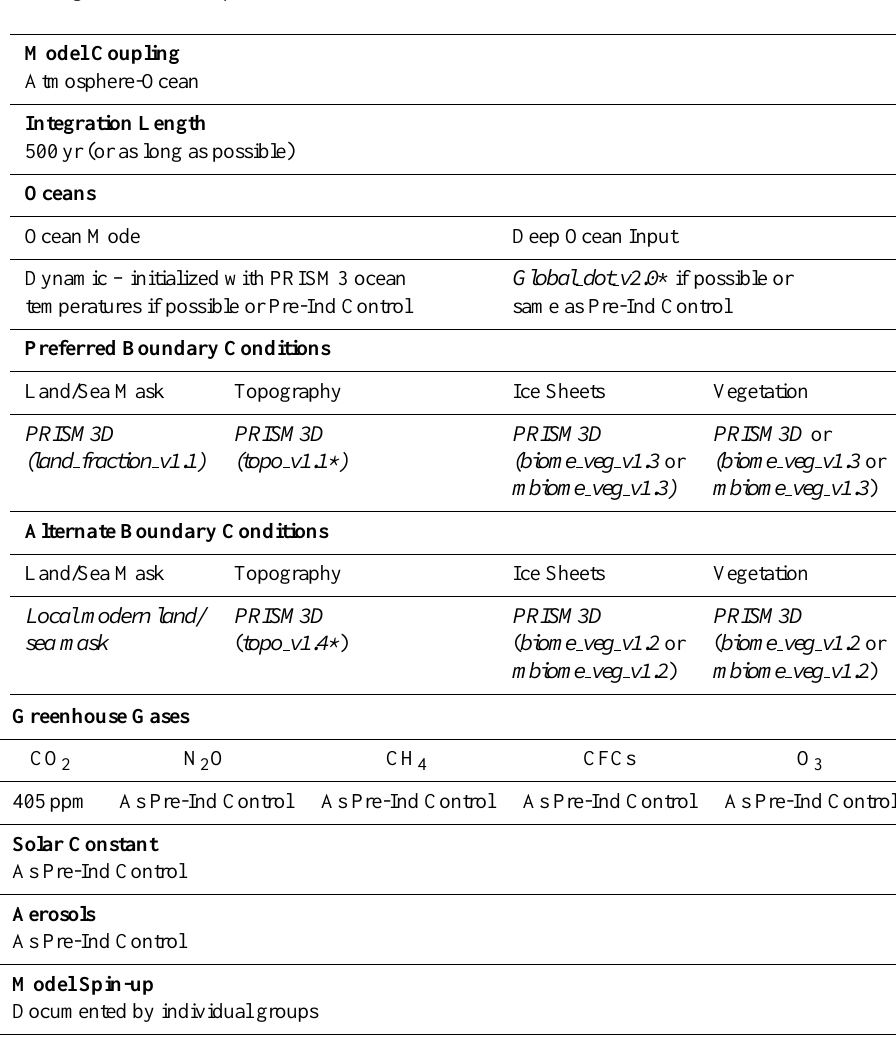
Table 1. Experimental design – PlioMIP Experiment